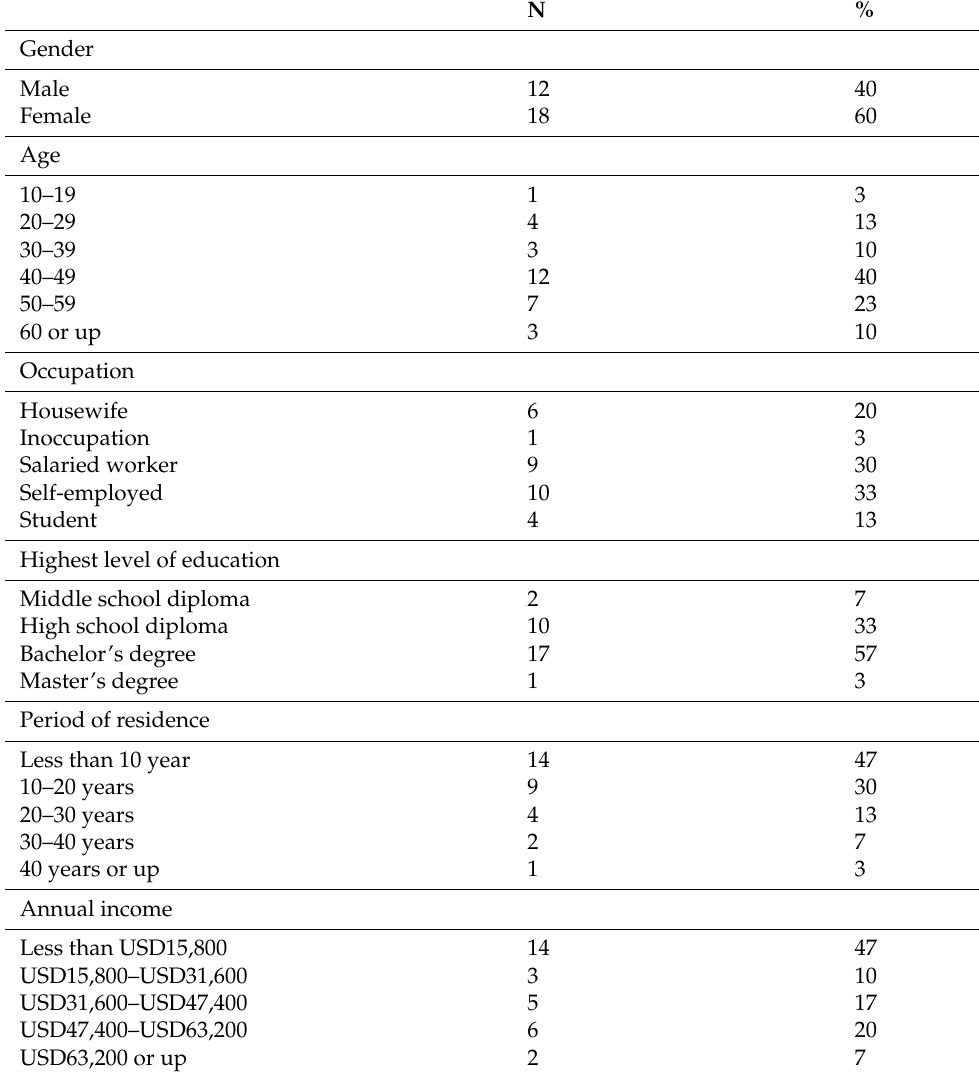
Table 2. Demographic and socio-economic characteristics of the